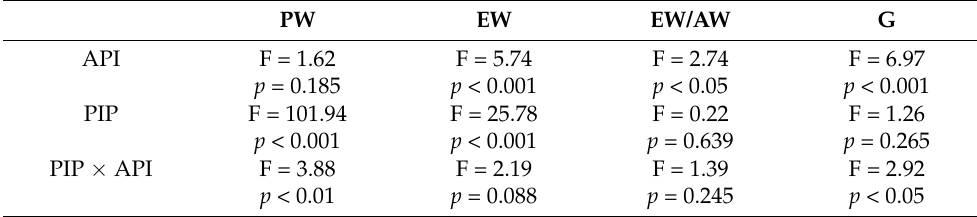
Table 3. Effect of the main factors and their interactions on achene characteristics. Results of the two-way analysis of variance (ANOVA). API—the achene position within the infructescence; PIP—the position of the infructescence on the plant; PW—pericarp weight; EW—embryo weight; EW/AW—embryo weight/achene weight ratio; G—germination